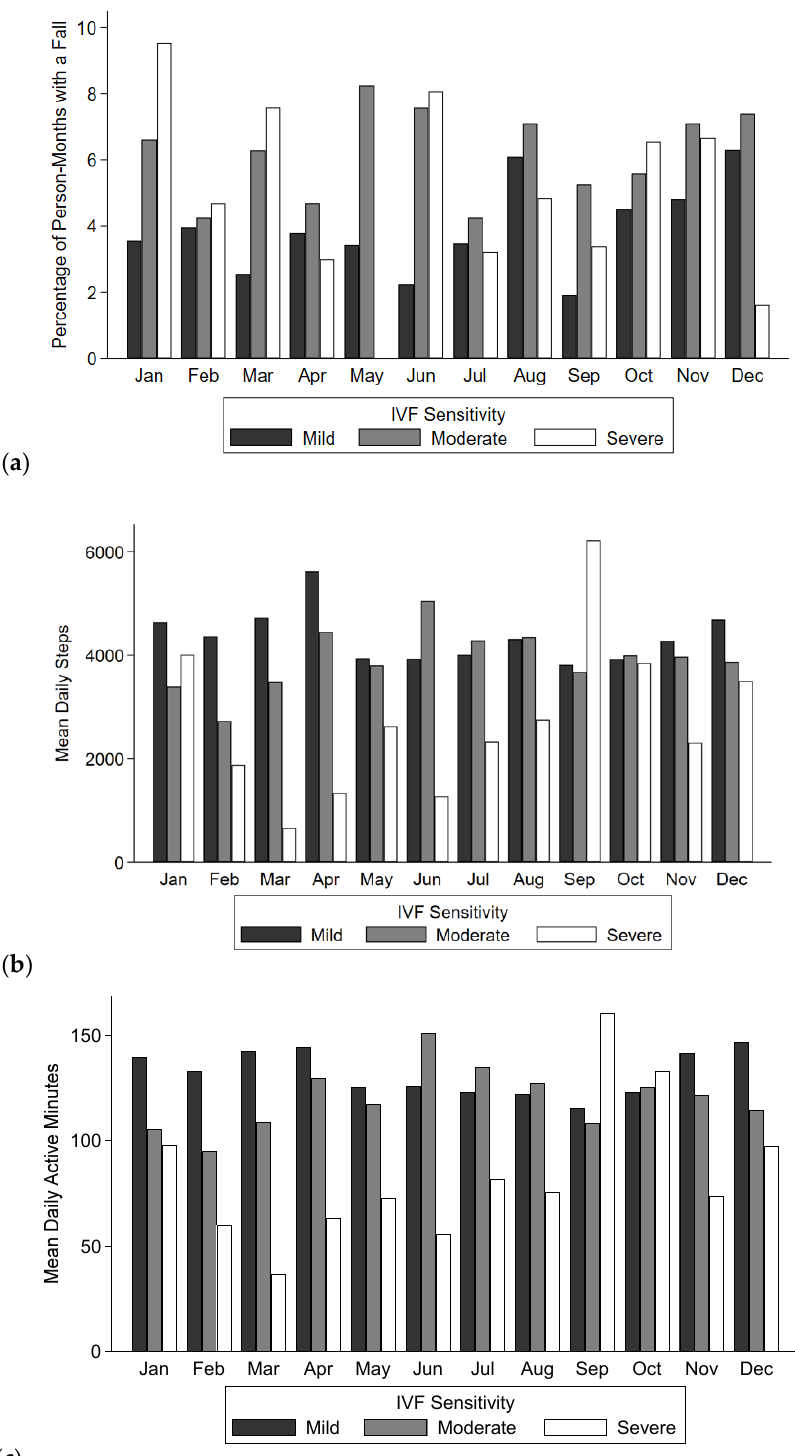
Figure 2. ( a ) Percent of months with a fall, ( b ) mean daily steps, and ( c ) mean daily active minutes by integrated visual field (IVF) severity group and month across all participants and the full study period. VF damage was categorized as mild (>28 dB in the integrated visual field), moderate (23–28 dB), or severe (<23 dB). ( a ) Approximately 114–118, 96–97, and 24–25 persons per month contributed to mild, moderate, and severe groups, respectively. ( b , c ) Per month, there were 19–53 person-weeks in the mild group, 17–41 person-weeks in the moderate group, and 2–14 person-weeks in the severe group.